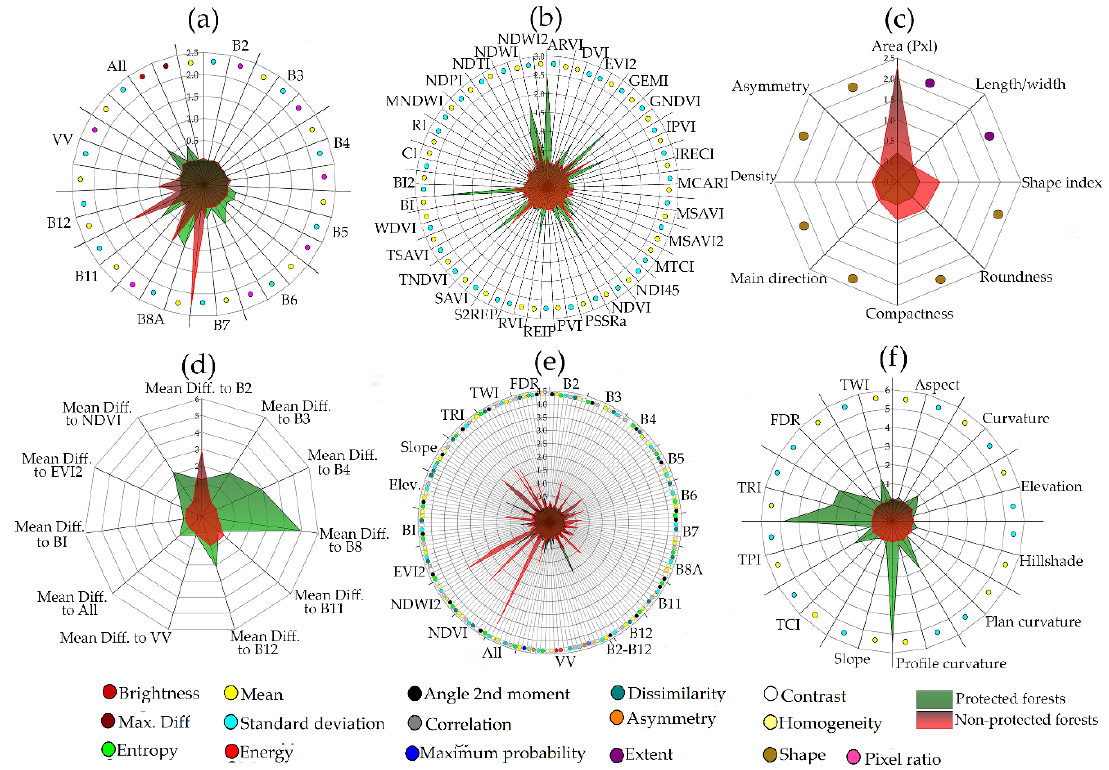
Figure 6. Comparison of the importance of sub-features derived from the Sentinel-1A, Sentinel-2A, combination of Sentinel-1 and -2A, and digital elevation model (DEM) for mapping historical landslides in the protected and non-protected forests. Between the spectral layers ( a ), the mean of narrow-near infrared band (B8A) and the standard deviation of the red-edge 3 band (B7), were the top features in the protected and non-protected forests. Between the spectral indices ( b ), the atmospherically resistant vegetation index (ARVI), second brightness index (BI2), and normalized di ff erence water index2 (NDWI2) are the three top features of the vegetation, soil, and water indices. Between the geometrical features ( c ), the area of extent features recorded the highest importance in the non-protected forests. Between the contextual features ( d ), the mean di ff erence to B8 showed the highest importance for mapping old landslides. Between the textural features ( e ), the standard deviation derived from the GLCM of the combination of all the bands of Sentinel-1 and -2A, and the contrast derived from the GLCM of the NDWI2 in the non-protected forests, and also the standard deviation derived from the GLCM of VV polarization of Sentinel-1A in the protected forests, are the top influential features. Between the topographic and hydrological features ( f ), the mean of slope, the mean of terrain ruggedness index (TRI), and the standard deviation of flow direction river (FDR), are top features for mapping old landslides. Note: B2: blue band; B3: green band; B4: red band; B5: red-edge 1 band; B6: red-edge 2 band; B7: red-edge 3 band; B8A: narrow-near-infrared band; B11: SWIR1 band; B12: SWIR2 band of Sentinel-2A; VV: VV polarization of Sentinel-1A; ALL: the combination of all the used Sentinel-1 and -2A bands. Definitions of other acronyms are available in Table